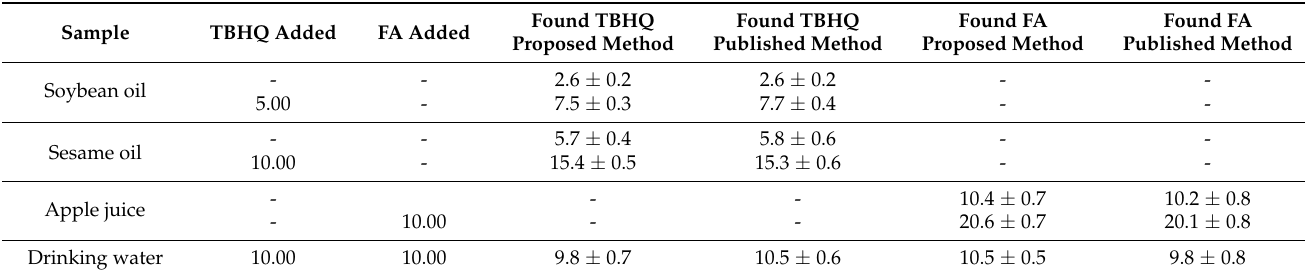
Table 5. Determination of TBHQ and FA in real samples (n = 4) [54]. The different results are compared to those from previously published methods for TBHQ [57] and FA [56], respectively.